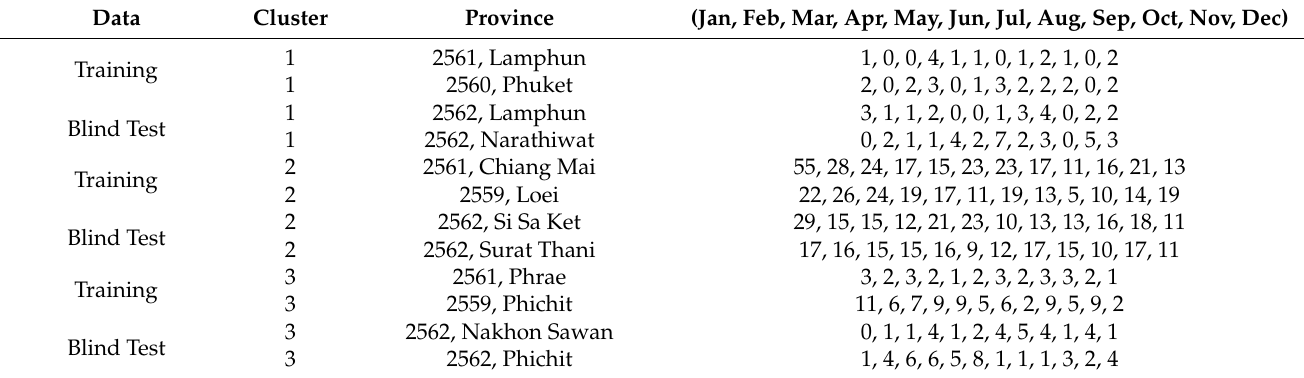
Table 17. The example of clustering results from the selected models for the HBV dataset for the month category. Data Cluster Province (Jan, Feb, Mar, Apr, May, Jun, Jul, Aug, Sep, Oct, Nov, Dec)